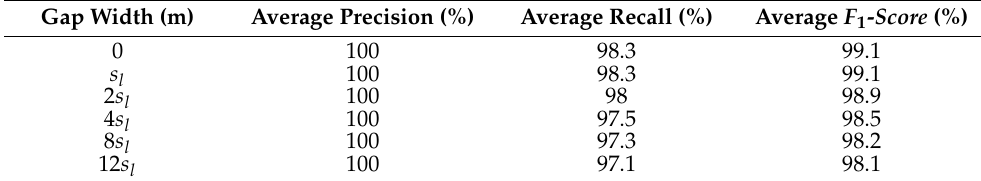
Table 3. Evaluation of powerline extraction.